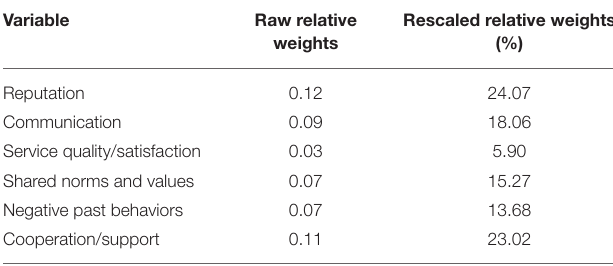
TABLE 4 | Raw and rescaled relative